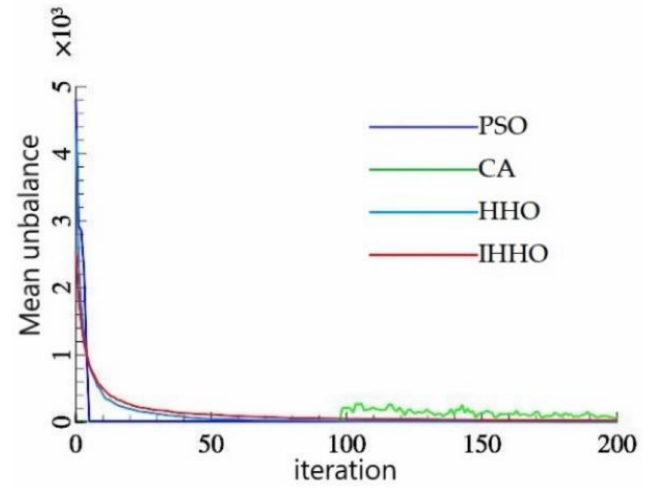
Figure 9. IHHO average unbalance iteration chart.